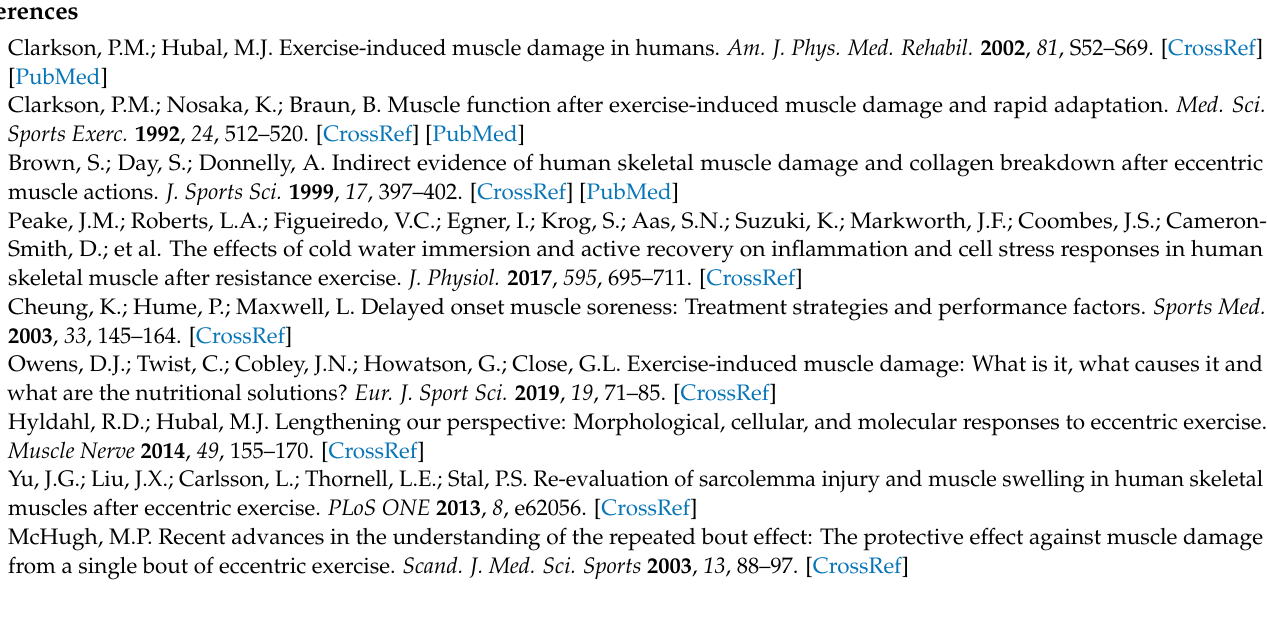
Table S2: Key concepts in bibliometrics and in network